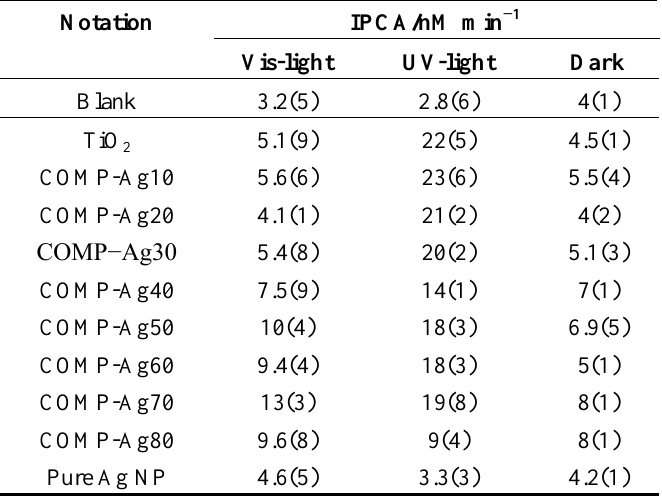
Table 2. The index of photocatalytic activity (IPCA) of decoloration rate of 1.0 × 10 −2 mM MB solution by photoreaction with each thin film and a blank.